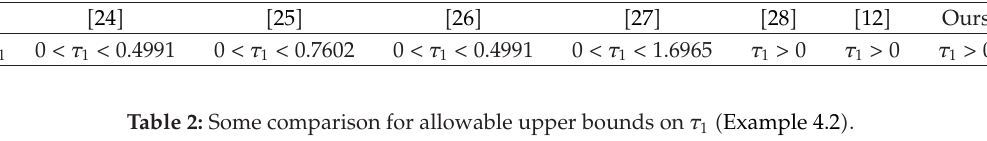
Table 1: Stability bounds of time delays (cid:2) Example 4.1 (cid:3) .